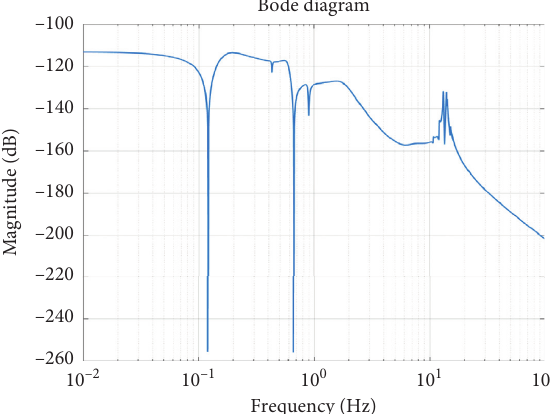
Figure 8: Closed-loop frequency magnitude response of the system with the H ∞